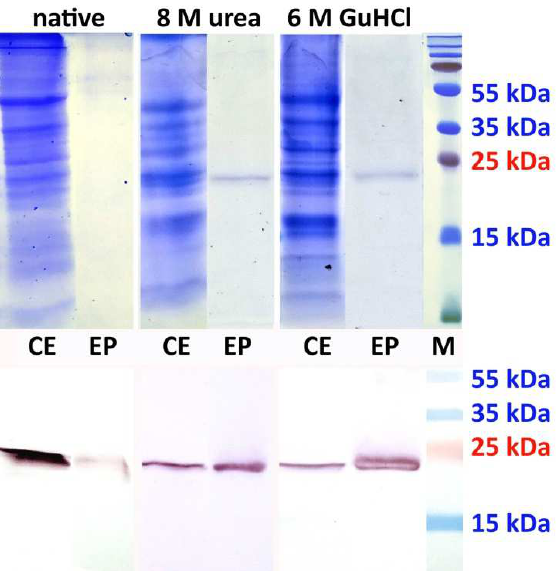
Figure 3. IMAC purification of CoN1-his under various conditions. Coomassie Brilliant Blue-stained gels (upper panel) and Western blot using anti-his antibody (lower panel). CE—crude leaf extracts; EP—eluted products; M—PageRuler Plus Prestained Protein Ladder (Thermo Scientific, Waltham, MA, USA).